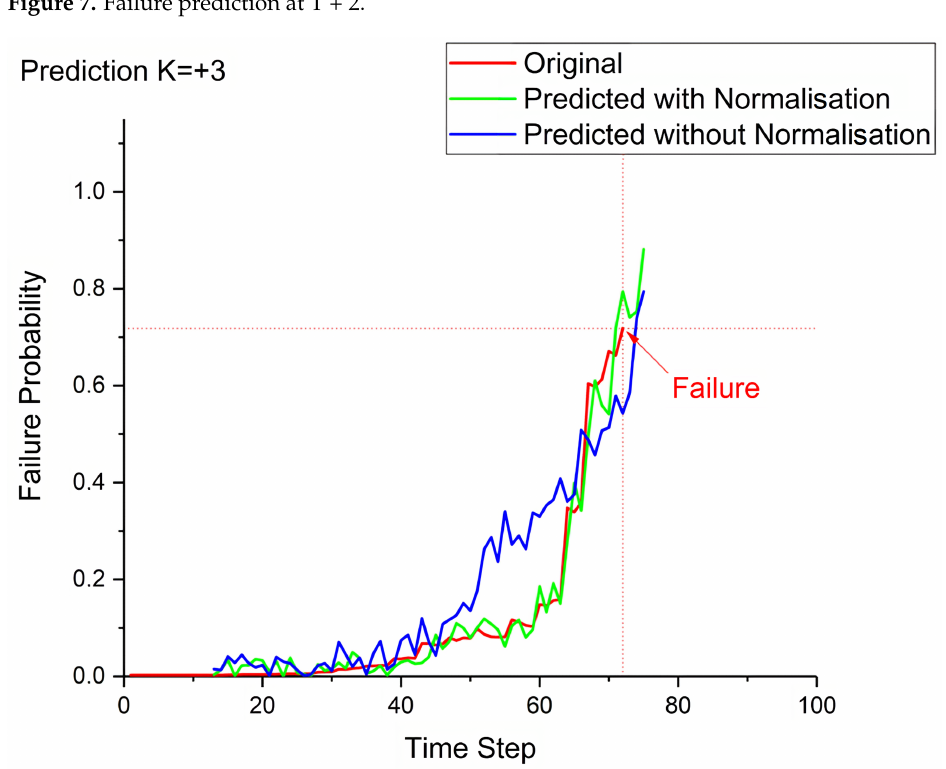
Figure 8. Failure prediction at T +